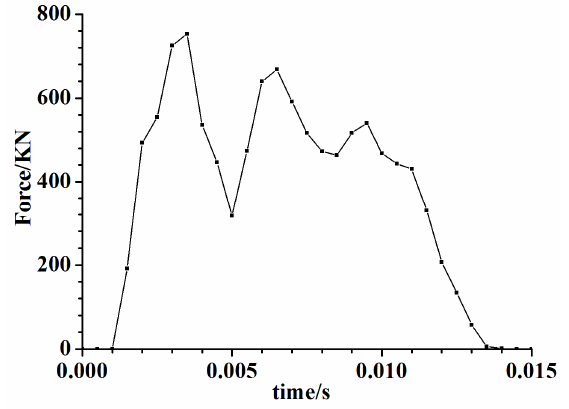
Figure 22. Collision force - time relationship of the stiffened plate obtained from simulation.